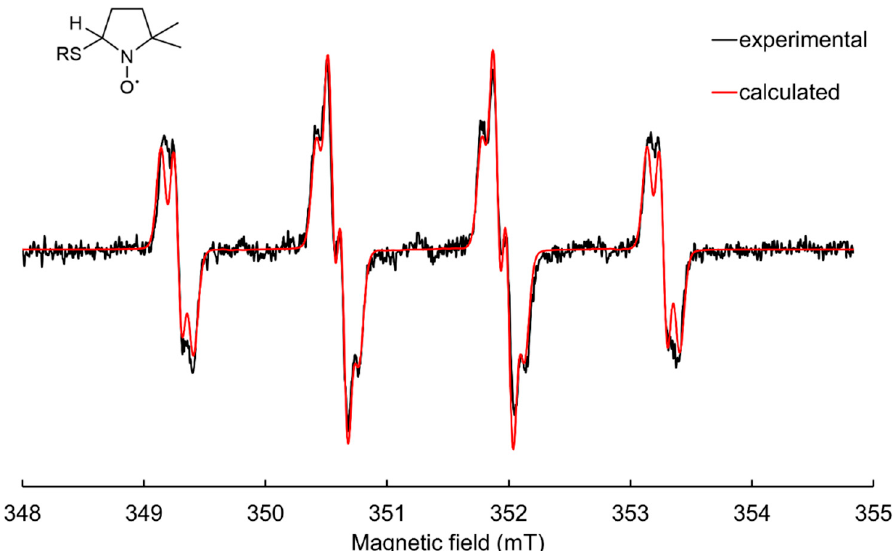
Figure 11. EPR signal observed in dichloromethane in the presence of DMPO and TT (~50 and 400 mM, respectively) in the absence of any light irradiation and resulting from the Forrester–Hepburn mechanism. The red trace corresponds to the EPR simulation using the following parameters: a N = 13.6 G, a H β = 12.8 G, a H γ = 0.9 and 1.1 G, and g = 2.0061, indistinguishable from that observed when trapping thiyl radicals.